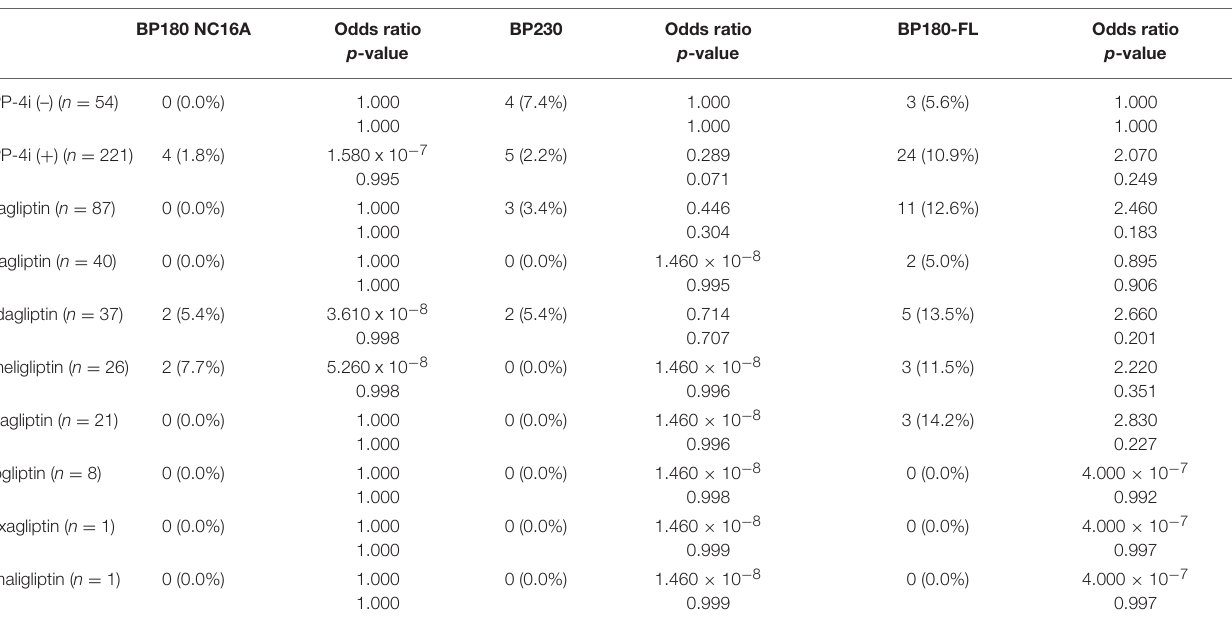
TABLE 1 | Positive rates of BP180 NC16A, BP230, and BP180-FL ELISAs for each DPP-4i